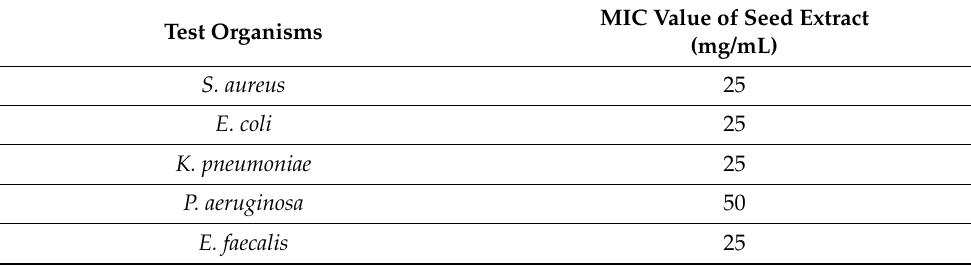
MIC Value of Seed Extract